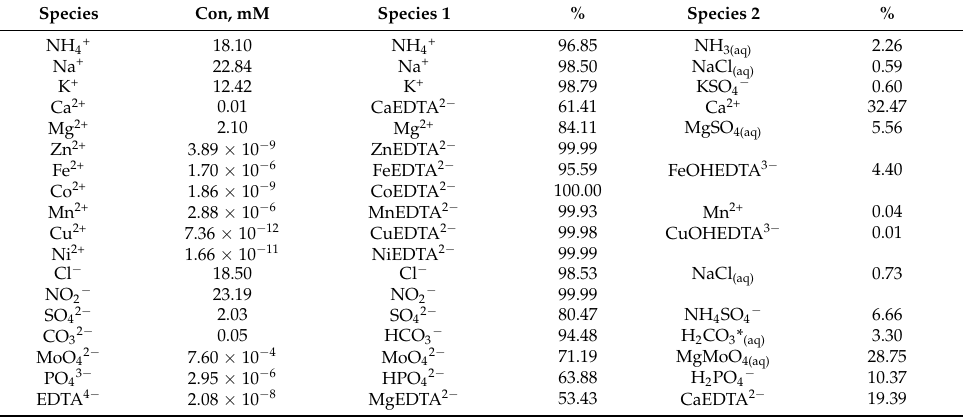
Table 1. The theoretical equilibrium speciation of synthetic wastewater (SW, pH = 8.7, IS = 100 mM) calculated by visual MINTEQ (version 3.1). Note: % is the weight percentage of species 1 or 2, * is unstable equilibrium